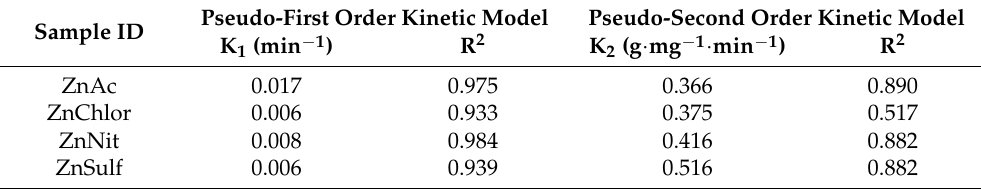
Table 8. Kinetic parameters of the ZnO powders under visible light